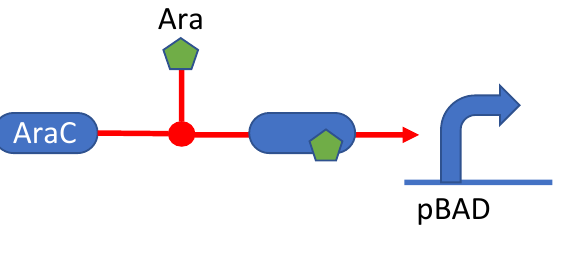
Figure 49: The AraC protein and arabinose associating into a complex that activates the pBAD